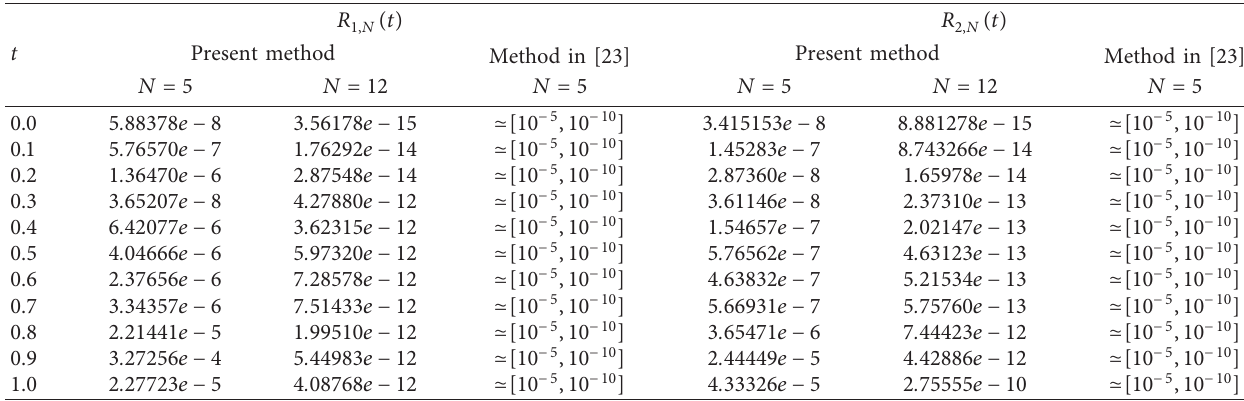
Table 1: Errors for Example 2.